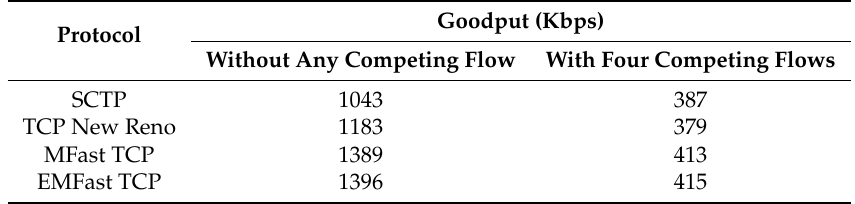
Table 3. End-to-end goodput of the protocols (average for five tests) [Table